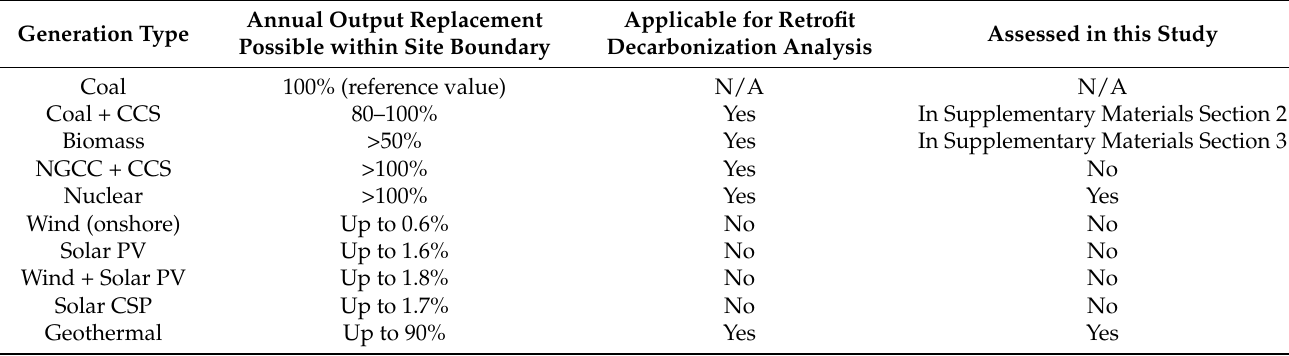
Table 1. Direct land use of low-carbon options compared to coal